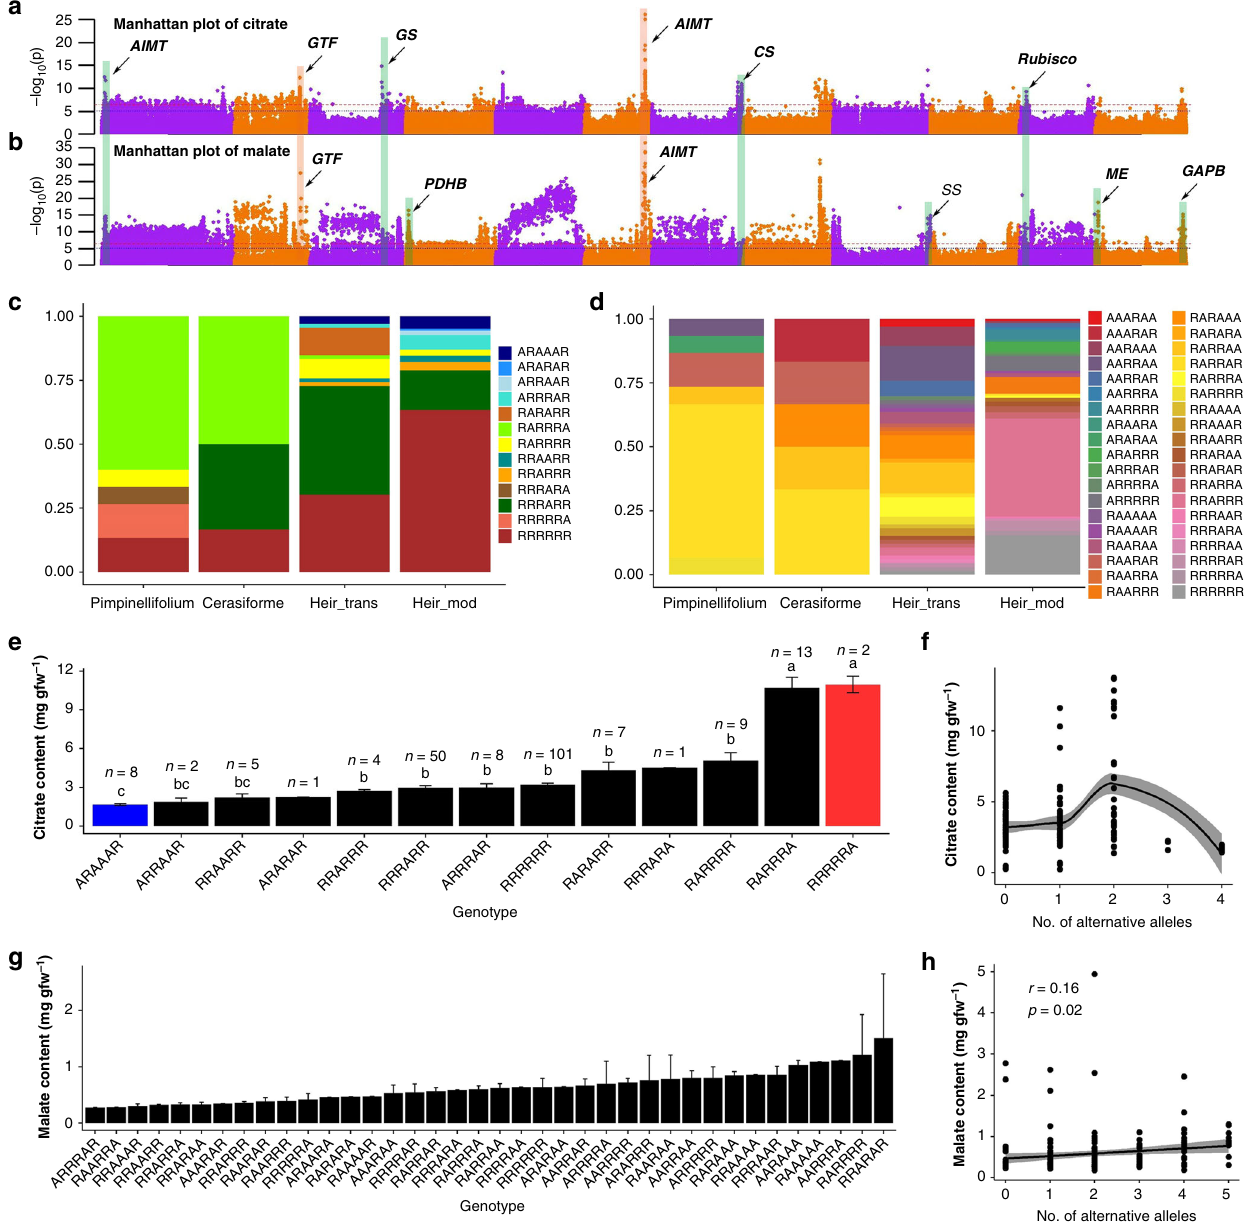
Fig. 3 Combinations of citrate and malate alleles for the improvement of tomato organic acid content. a , b Manhattan plot for meta-analysis of genome- wide association analysis of citrate ( a ) and malate ( b ) content. AIMT, Aluminum-activated malate transporter ; GTF, Glycosyl transferase group 1 ; GS, Glycogen synthase ; AIMT, Aluminum-activated malate transporter ; CS, Citrate synthase ; Rubisco, Ribulose-1 5-bisphosphate carboxylase/oxygenase activase 1 ; PDHB, Pyruvate dehydrogenase E1 component subunit beta ; SS, Sucrose synthase ; ME, Malic enzyme ; GAPB, Glyceraldehyde-3-phosphate dehydrogenase B . c Allele distribution of citrate content at positions: chr1:1749084, chr2: 47,904,426, chr3: 52,998,165, chr6: 44,955,568, chr7: 63,601,724, and chr10: